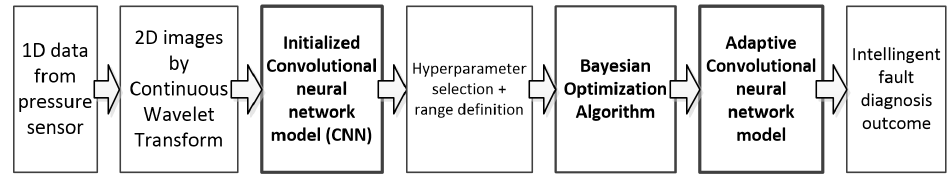
Figure 12. Flowchart of a piston pump fault diagnosis based on a pressure signal by